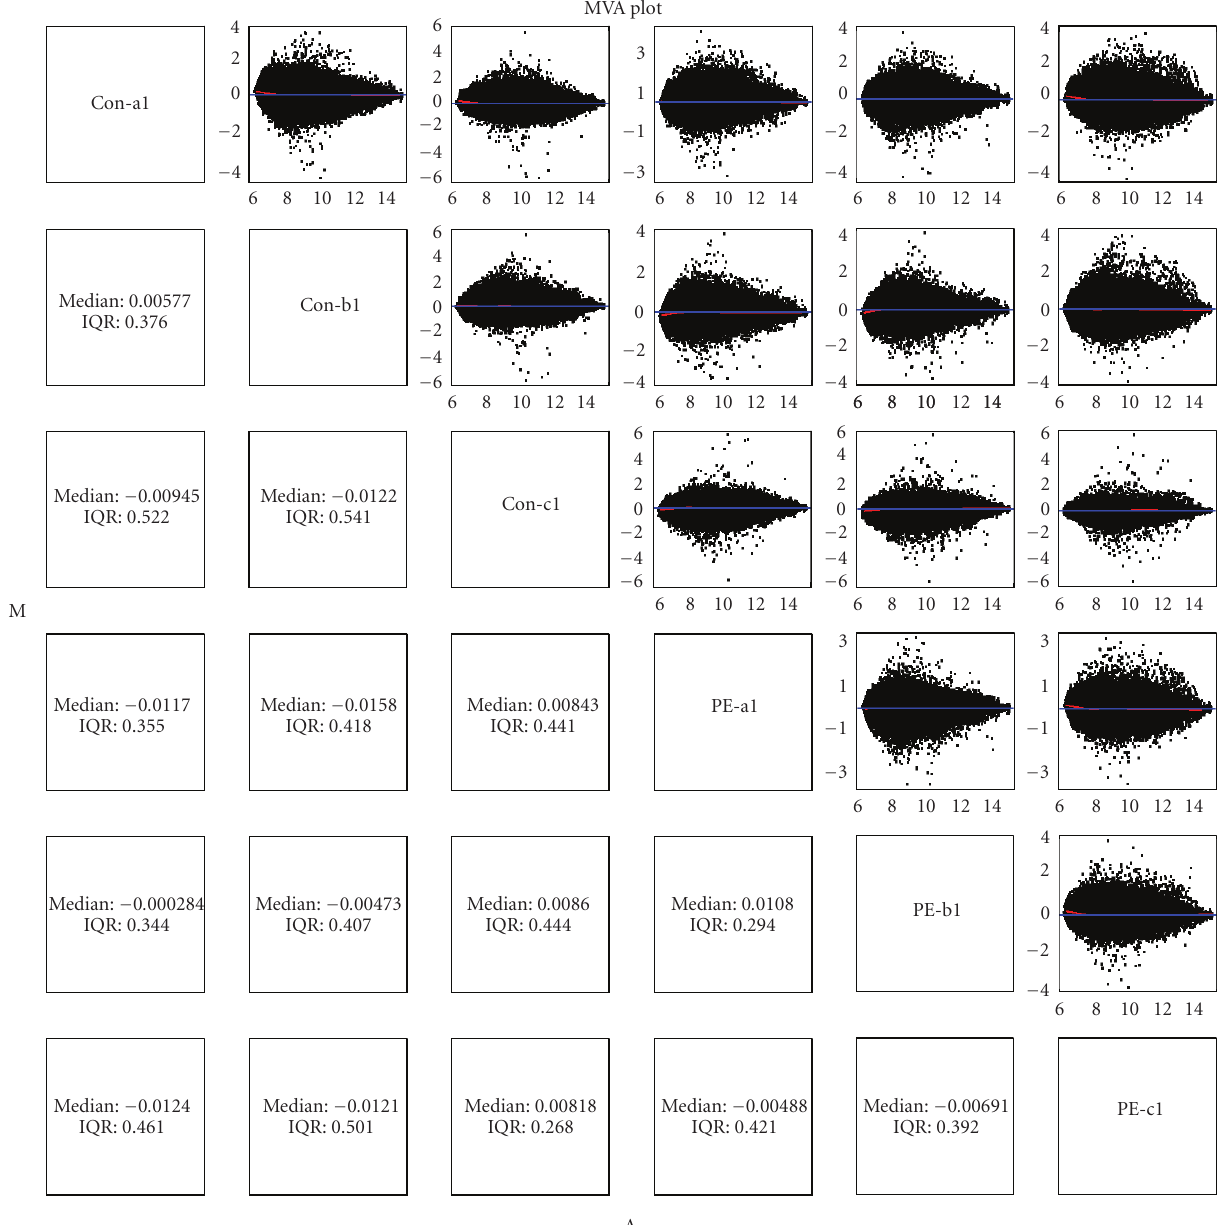
Figure 1: The interquartile range (IQR) values for the MVA plots show that the variation between the arrays within each group (case versus case or control versus control) is in the same range as the variation between the groups (case versus control). This indicates a high similarity between the case and control groups which is also apparent by the relatively low number of di ff erentially expressed genes